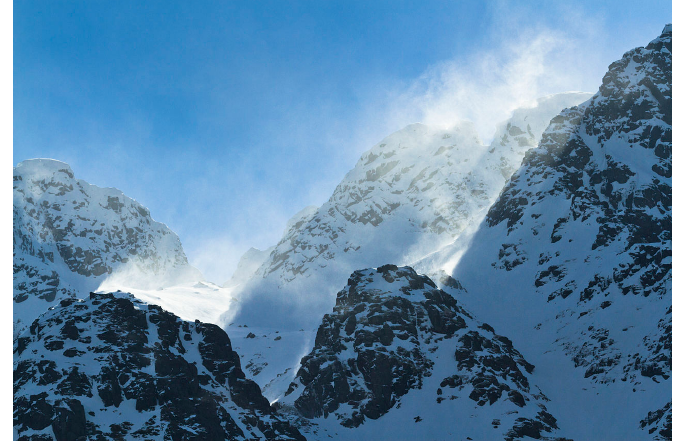
Figure 2. Blowing snow at high elevations affects the spatial distribution of snow and wind loading of avalanche initiation zones. Simo